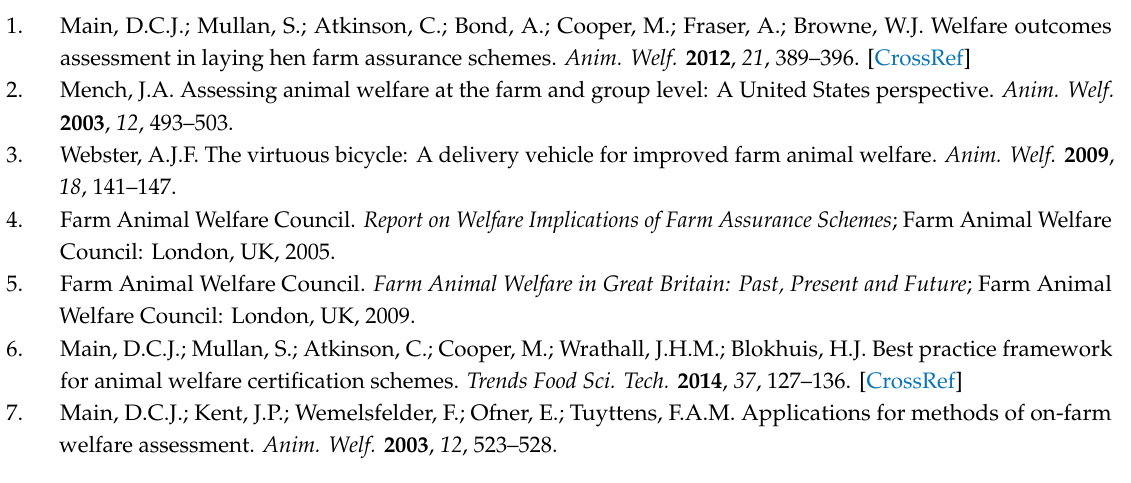
Table S1: Sample characteristics (N = 49), Table S2: Costs considered in economic analysis, Table S3: Total cost to satisfy each resource tier (£), Table S4: Incremental cost to satisfy higher resource tiers (£), Table S5: Correlation coe ffi cients amongst resource tier scores and estimated cost, Table S6: p -values for correlations amongst resource tier scores and estimated cost, Table S7: p -values for correlations between resource tier scores and welfare outcome